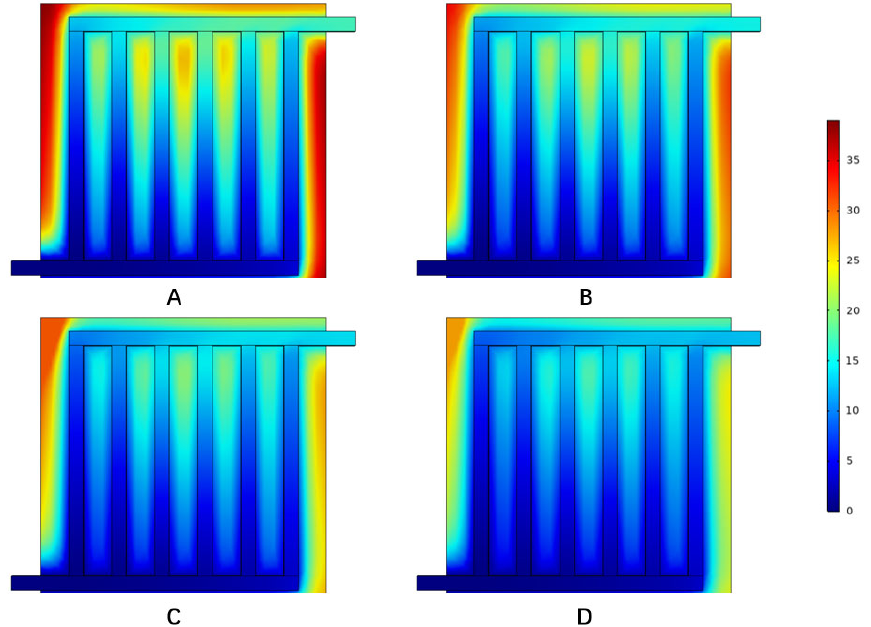
Figure 7. Oxygen mole fraction distribution under different temperatures: ( A ) 40 ℃ , ( B ) 80 ℃ , ( C ) 120 ℃ , and ( D ) 160 ℃ .